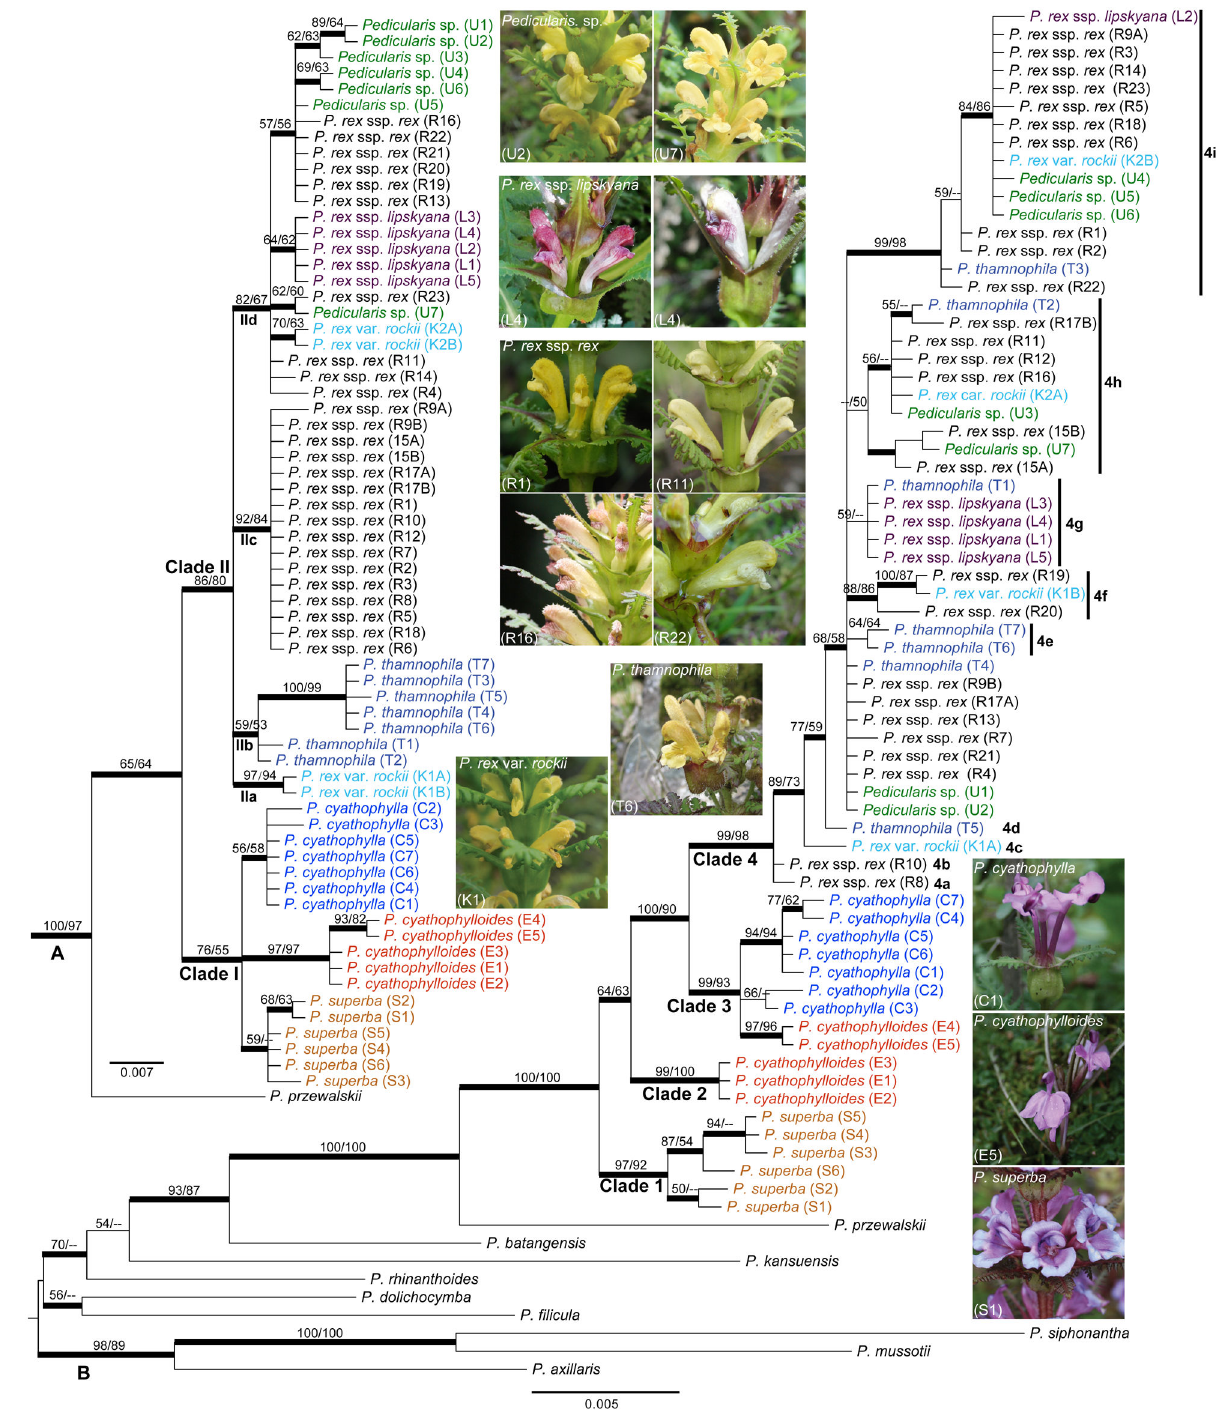
Figure 2. Phylogenies of Pedicularis section Cyathophora inferred from Bayesian, maximum likelihood and maximum parsimony methods using nrITS (A) and the concatenated chloroplast (B) datasets. Topology shows the majority rule consensus of the Bayesian inference tree, with thicker lines for the posterior support ≥ 0.95. Bootstrap values (≥50) of maximum likelihood/parsimony are indicated above branches. Sample code indicated in the parenthesis after species name and on the species photo is summarized in Table